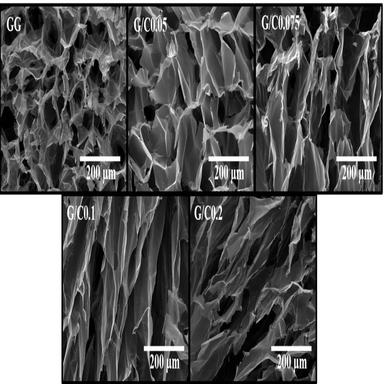
Morphological analysis under SEM.